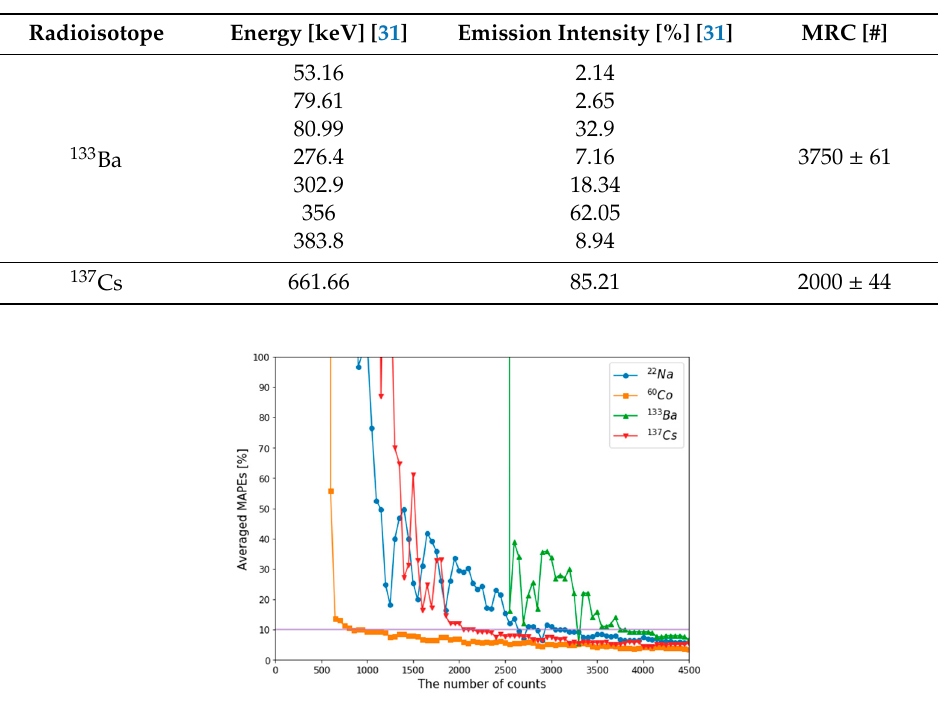
Figure 9. Averaged MAPEs according to the number of counts for single isotope gamma spectra.